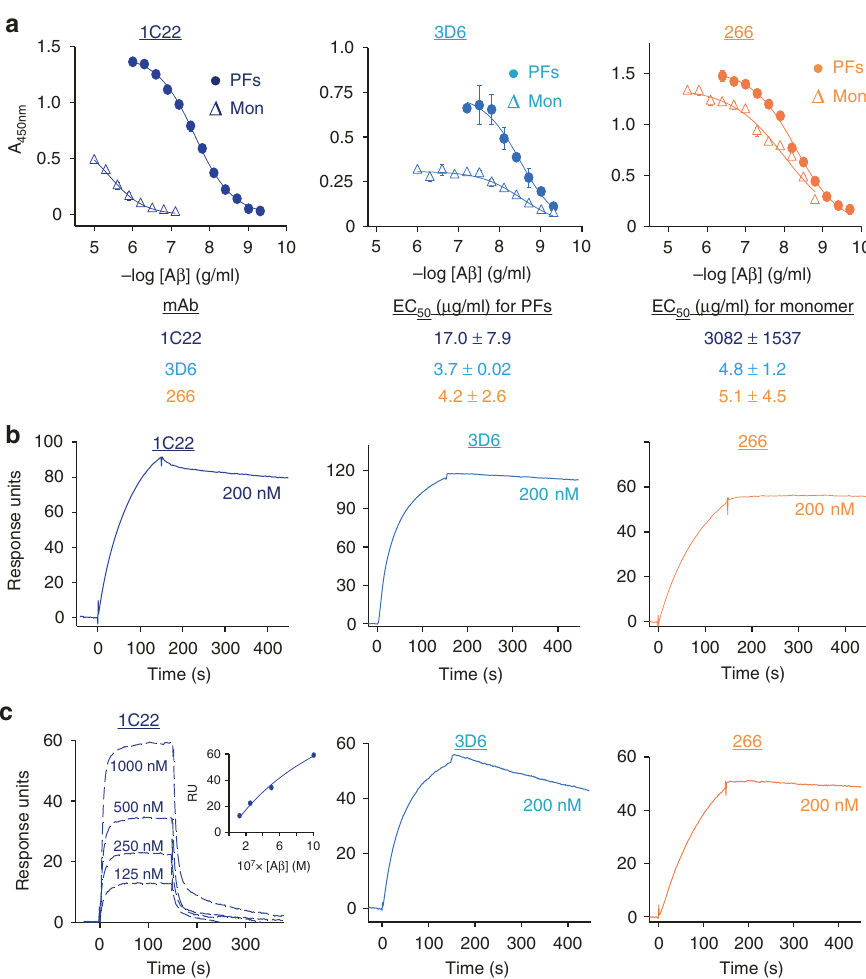
Fig. 2 Surface-immobilized 1C22 mAb preferentially binds to PFs in solution. a mAbs 1C22, 3D6, and 266 were immobilized on the wells of microtiter plates and allowed to bind solution-phase proto fi brils (PFs) and A β monomers (Mon). Antibody binding curves were sigmoidally fi t and used to determine the concentration of antibody that gave half-maximal binding, EC 50 . When error bars are not visible they are smaller than the size of the symbol. Values in the table are in μ g/ml and are the average ± SD of each condition analyzed in triplicate. Antibodies were immobilized on CM5 chips and solution-phase b PFs, or c Mon added. The molar concentration of A β monomers and PFs (wrt to A β monomer content) used is indicated on each sensogram. Except for A β monomer binding by 1C22, sensograms for mAb binding to A β monomers were fi t to a 1:1 langmuir binding model. Sensograms for 1C22 binding to A β monomers were fi t to steady state analysis. The inset in c panel 1 is a plot of response units (RU) at steady state for A β monomers binding to chip-immobilized 1C22. The apparent binding constant ( K APP ) of mAbs for PFs are: 1C22 < 1 nM; 3D6 < 1 nM; 266< 1 nM, and the binding constants ( K D ) for Mon are: 1C22 = 1100 ± 500 nM; 3D6 = 7.9 ± 0.16 nM; and 266 = 2.1 ± 1.8